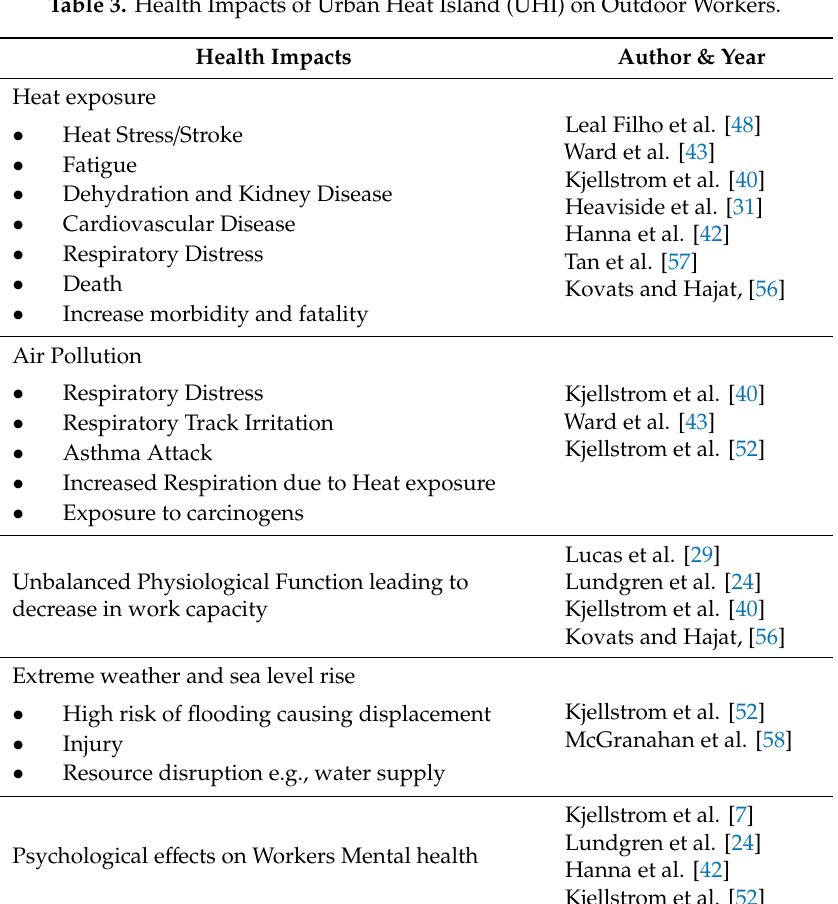
Table 3. Health Impacts of Urban Heat Island (UHI) on Outdoor